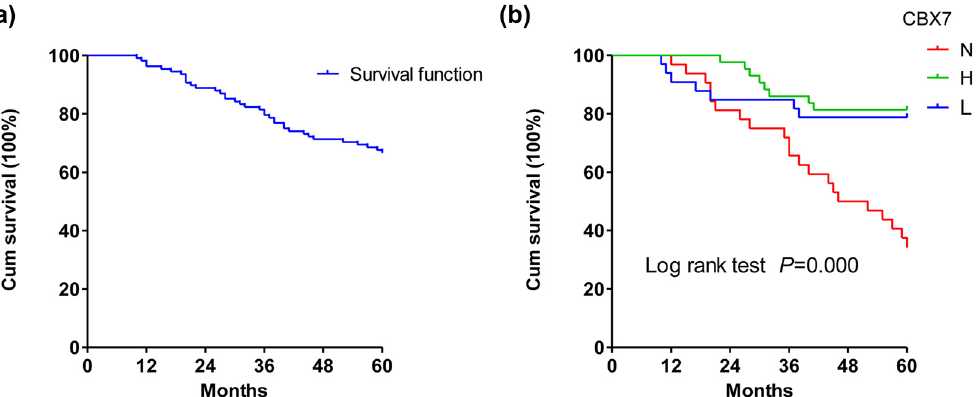
Figure 1: Survival curves of patients with CC. ( a ) OS curve. ( b ) Survival of patients with tumors lacking ( N ) or expressing low ( L ) or high ( H ) levels of